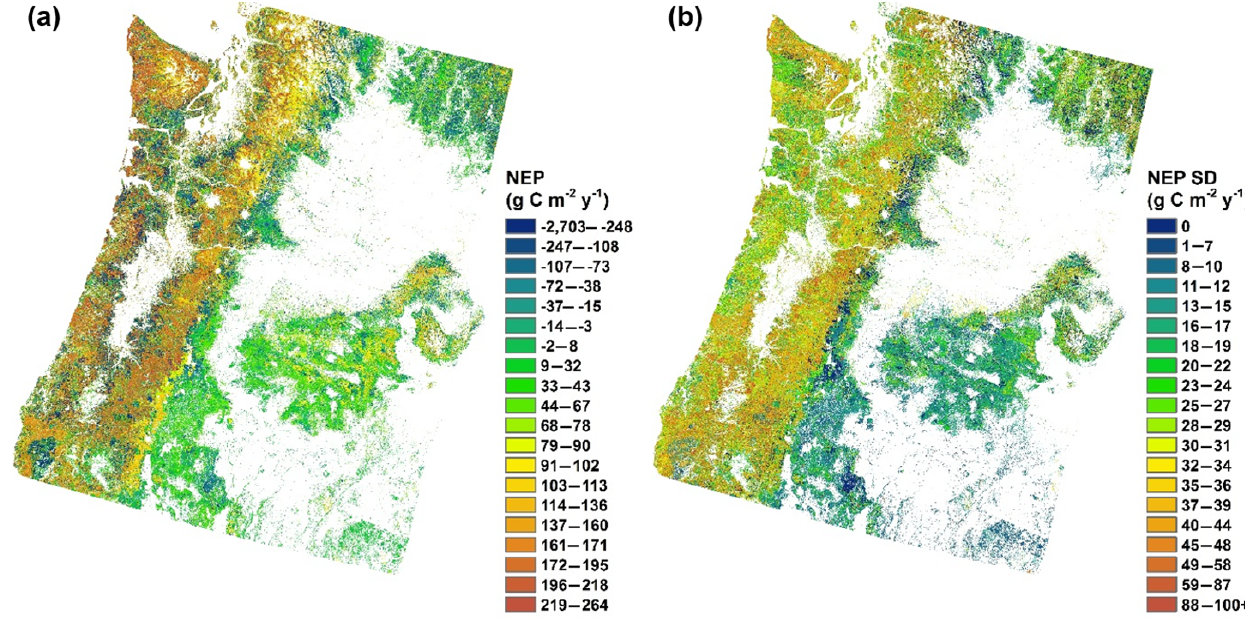
Figure 8. Maps of (a) net ecosystem productivity (NEP) and (b) standard deviation in 2010 in the PNW region.